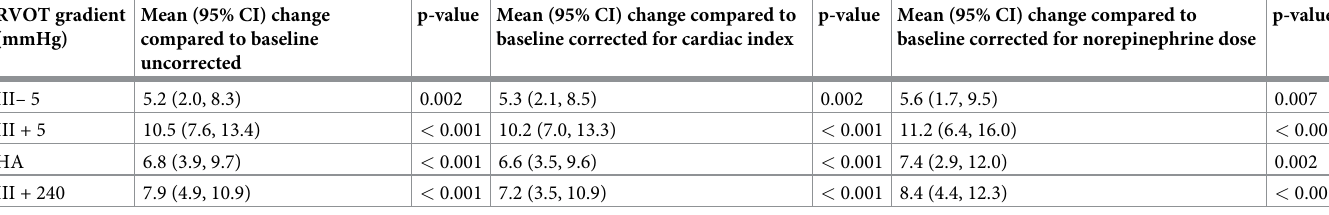
Table 4. Effects of cardiac index and norepinephrine dose on the measurement of RVOT gradient. RVOT gradient Mean (95% CI) change (mmHg) compared to baseline